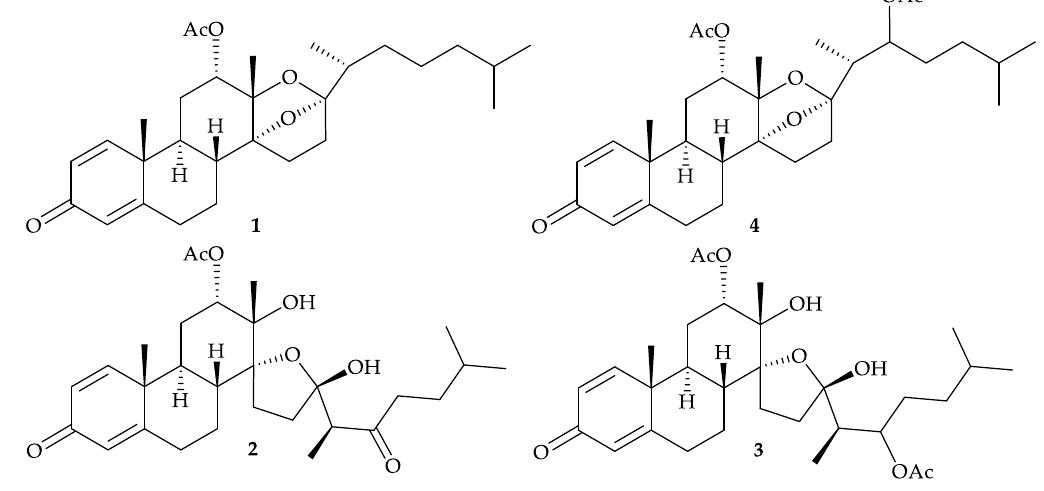
Figure 1. Structures of isogosterones A–D ( 1 – 4 ).